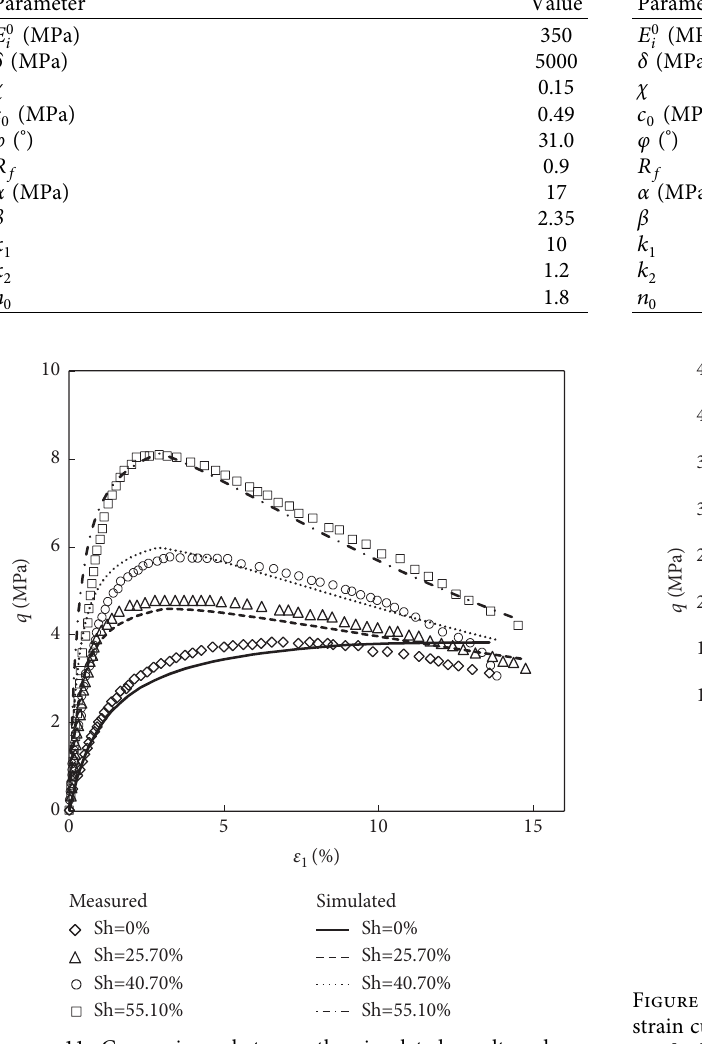
Figure 11: Comparisons between the simulated result and ex- perimental data for hydrate-bearing Toyoura sand [35].